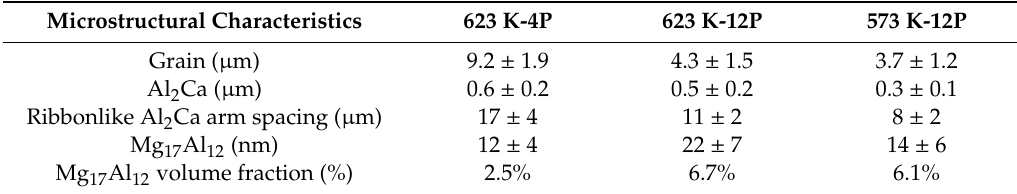
Table 1. Microstructural characteristics of ECAP-ed